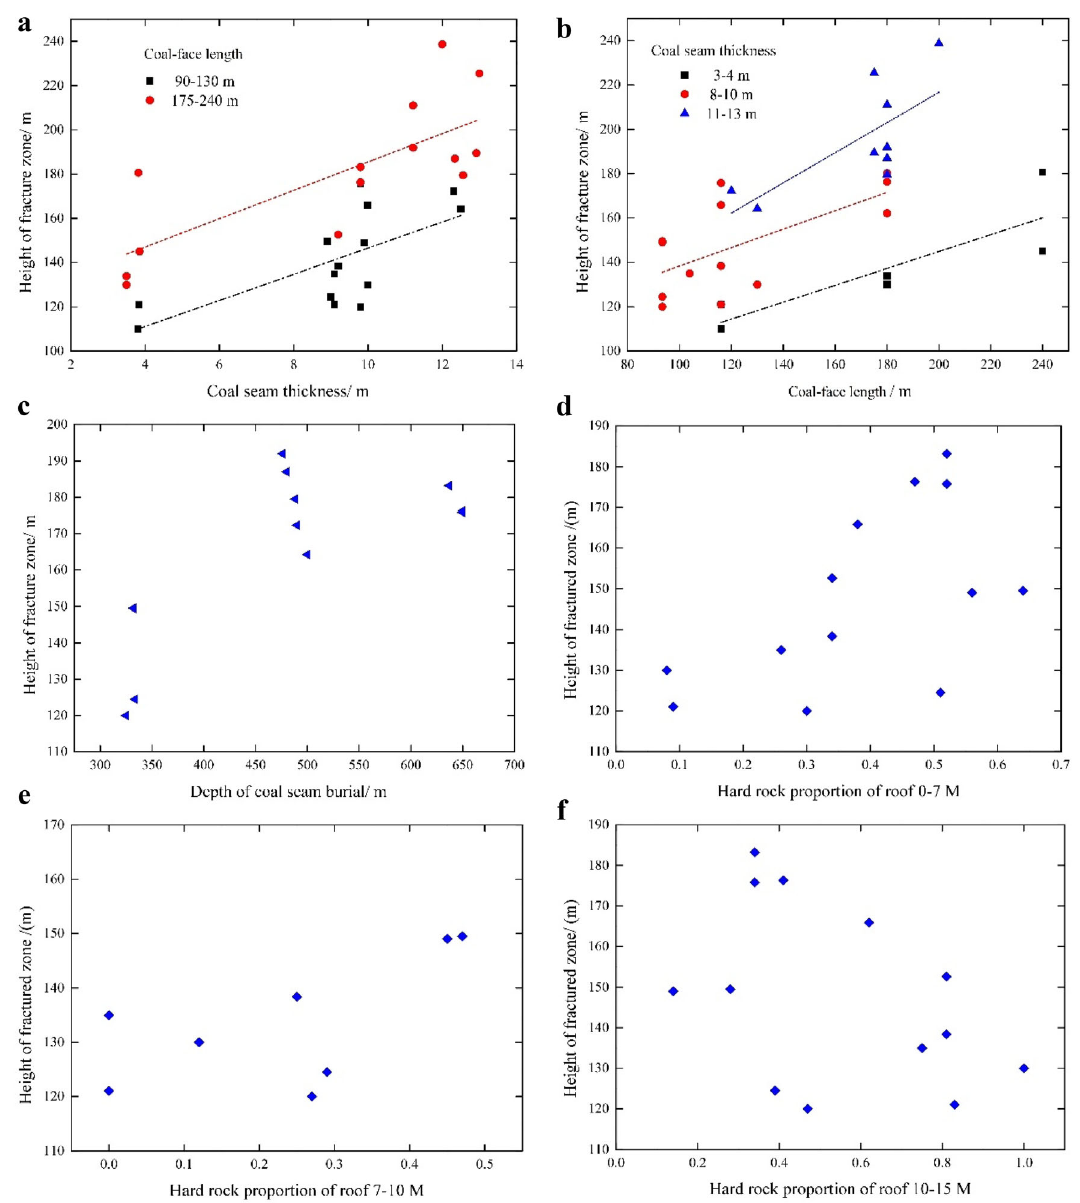
Fig. 2 Correlation between WFFZ height and coal seam thickness, working face length, coal seam burial depth and hard rock proportion of